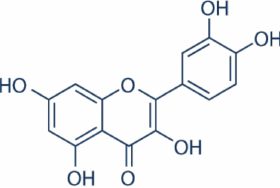
Figure 9. The chemical structure of